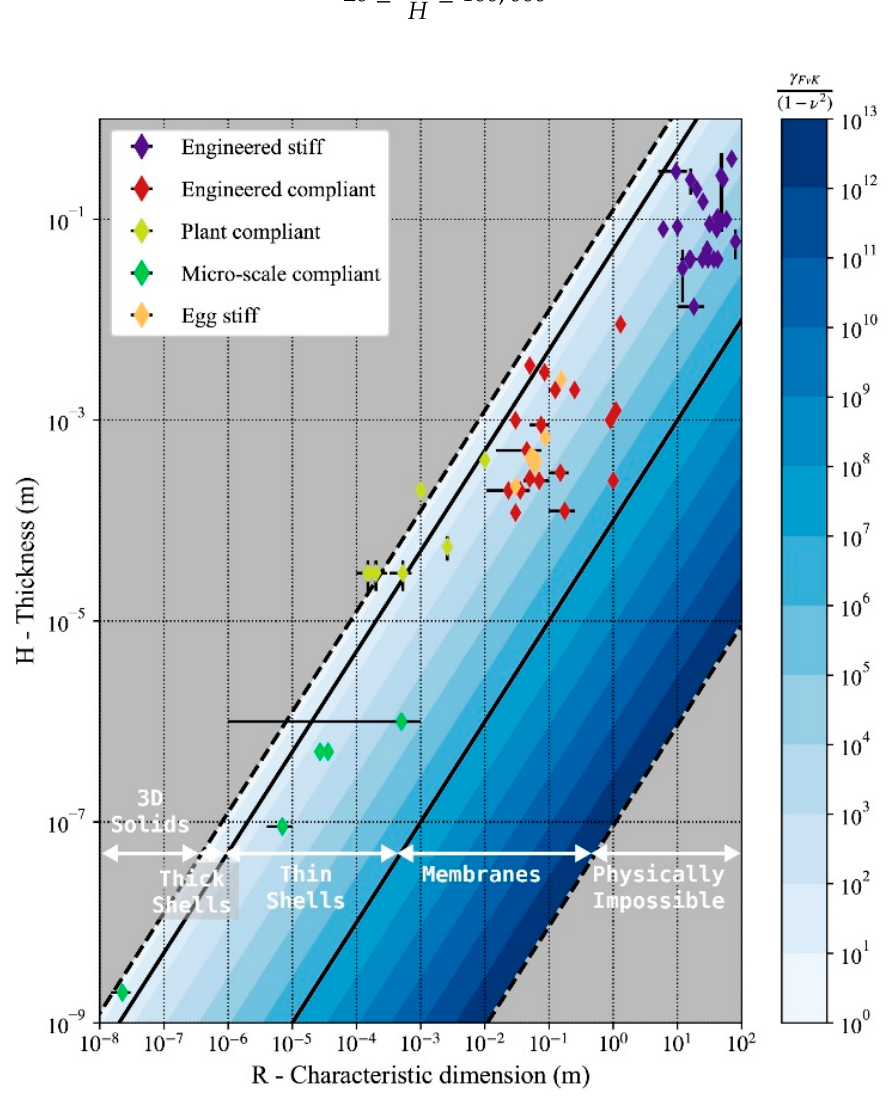
Figure 2. Geometric properties and γ FvK values for stiff and compliant thin shells, plant compliant thin shells, and compliant micro-scale shells. The scale for both axes is logarithmic. Table 1. Average values of γ FvK for the five types of